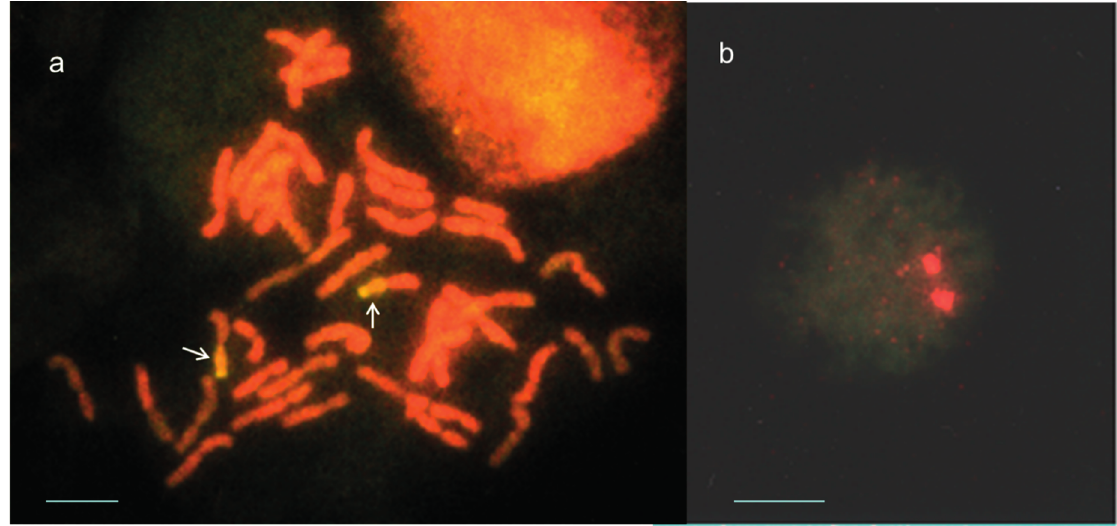
Figure 2. Genomic in situ hybridization (GISH) results of line S148. ( a ) Two translocated chromosome segments (arrows) originated from Th. ponticum were visualized in a mitotic metaphase cell; ( b ) Two fluorochrome signals of Th. ponticum were detected in a mitotic interphase cell. Bars represent 10 μ